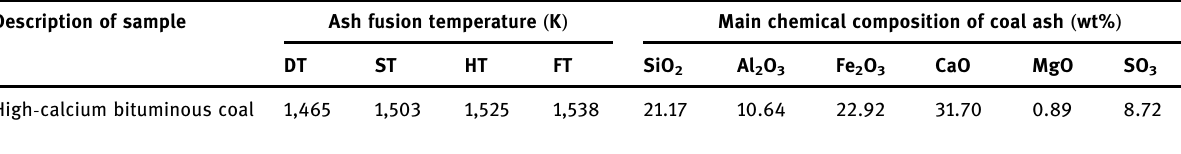
Table 2: Ash fusion temperature and main chemical composition of coal ash a